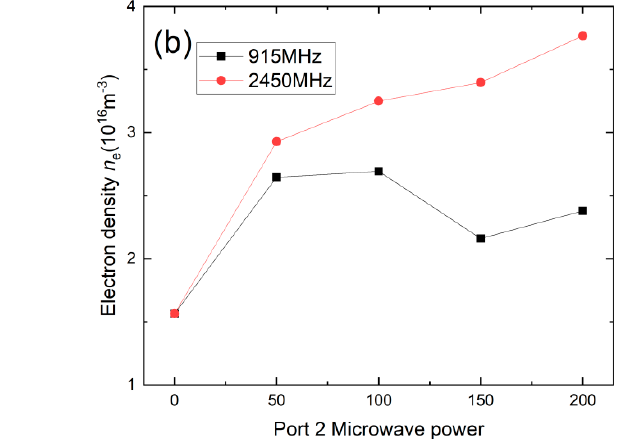
Figure 3. Effect of the microwave inputted from port 2 measured by the Langmuir probe: ( a ) electron temperature; ( b ) electron density.